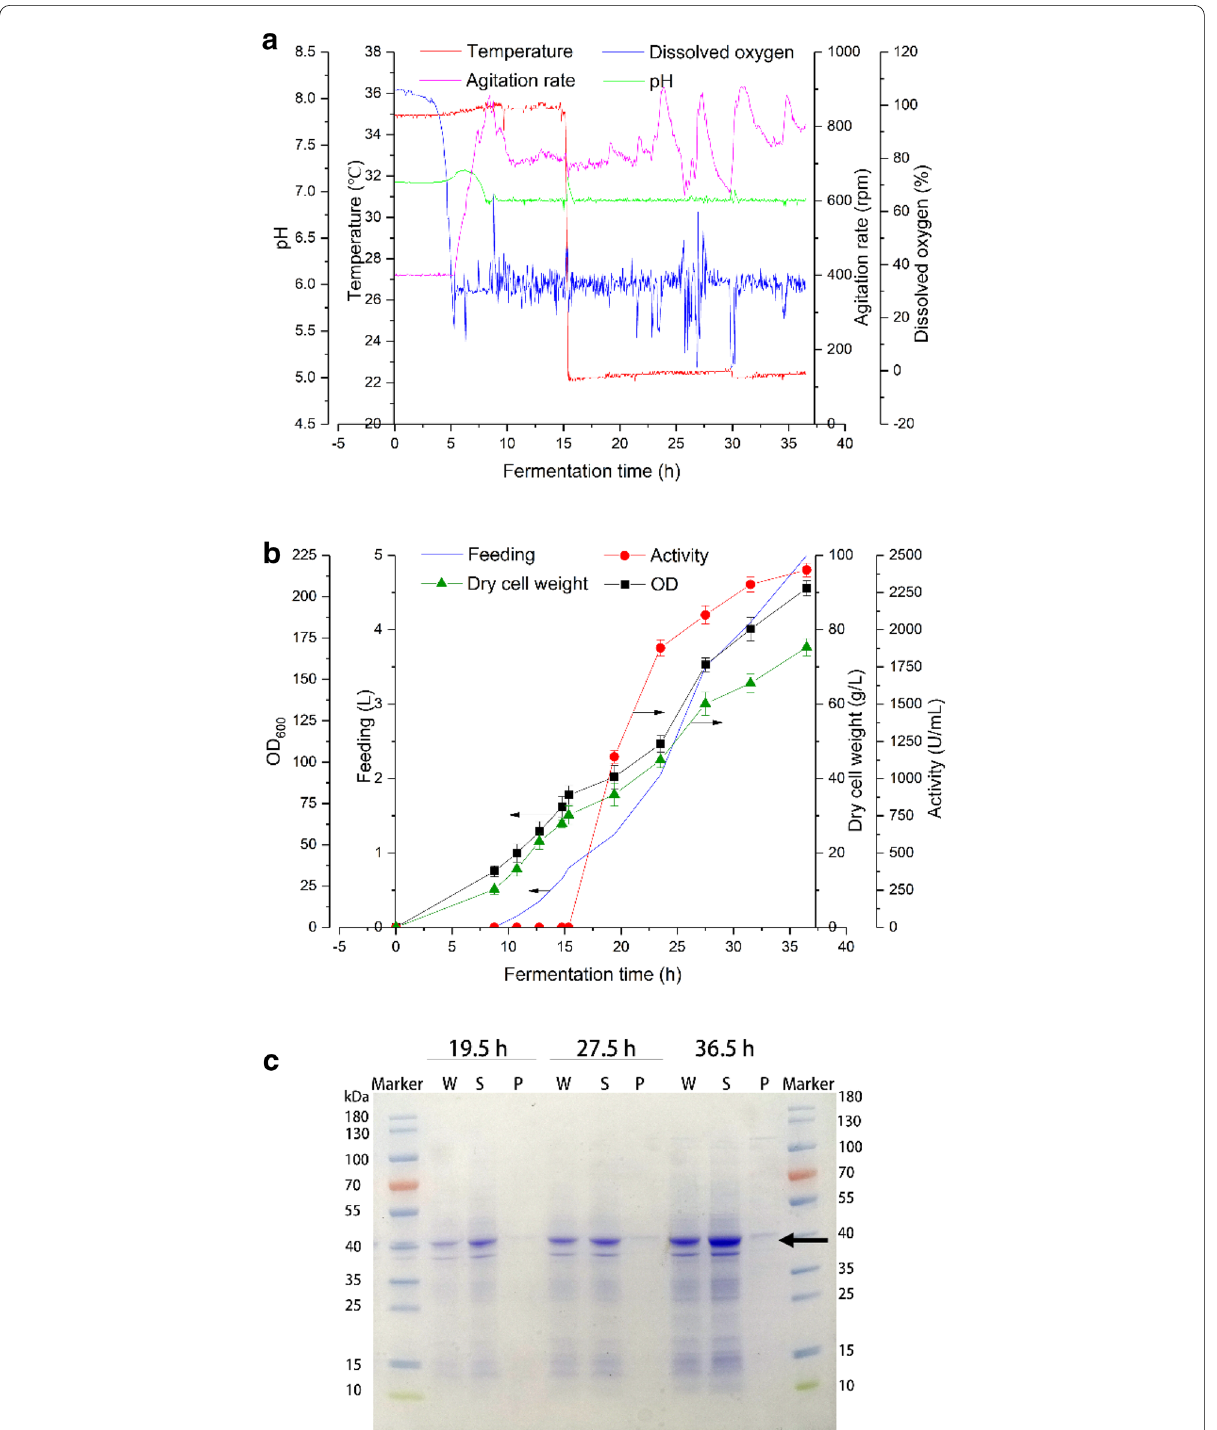
Fig. 6 Fermentation process of recombinant Escherichia coli -pET-28a-CbADH-6M in a 15.0-L mechanically stirred fermentor. a Fermentation parameter control. b Cell growth and CbADH-6M expression during the fermentation. c SDS-PAGE analysis of protein expression of samples at different time: Lane M: molecular weight marker; Lane W: whole cell protein; Lane S: supernatant; Lane P: